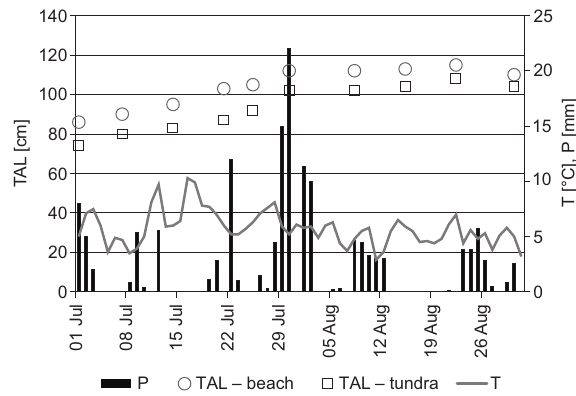
Fig. 3. Thickness of the active layer (TAl) in the area of Kaffiøyra plain in relation to air temperature (T) and precip- itation (P) in the period 1.07–5.09.2004 (acc. to Sobota